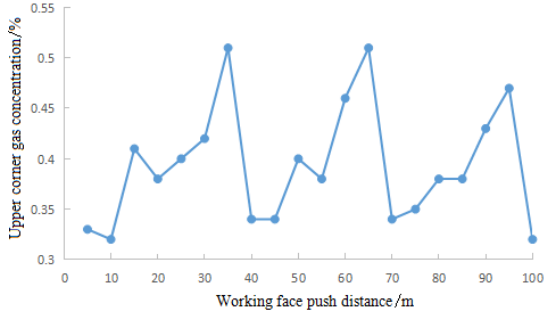
Figure 9. Variation of the methane concentration in the upper corner.